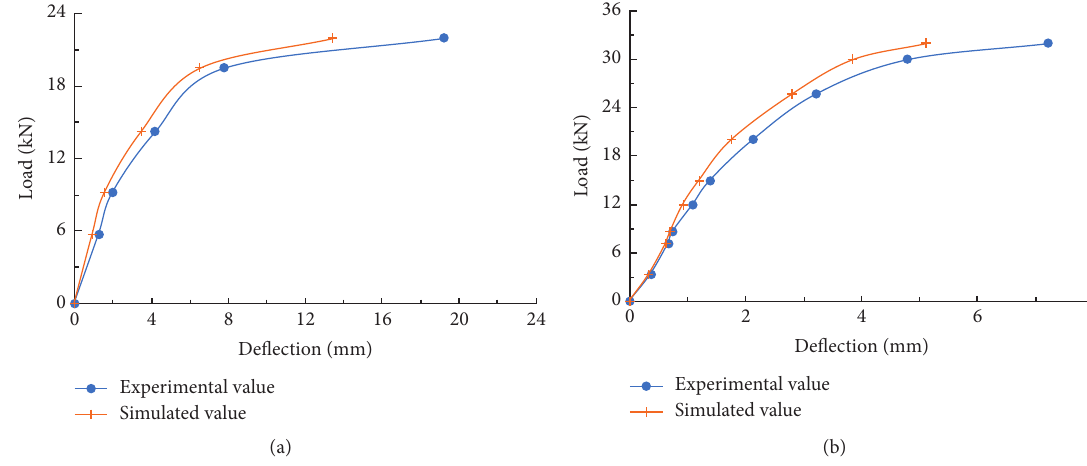
Figure 11: The midspan deflection-load curve of top slab of BCs. (a) Round hinged type. (b) Integral type.